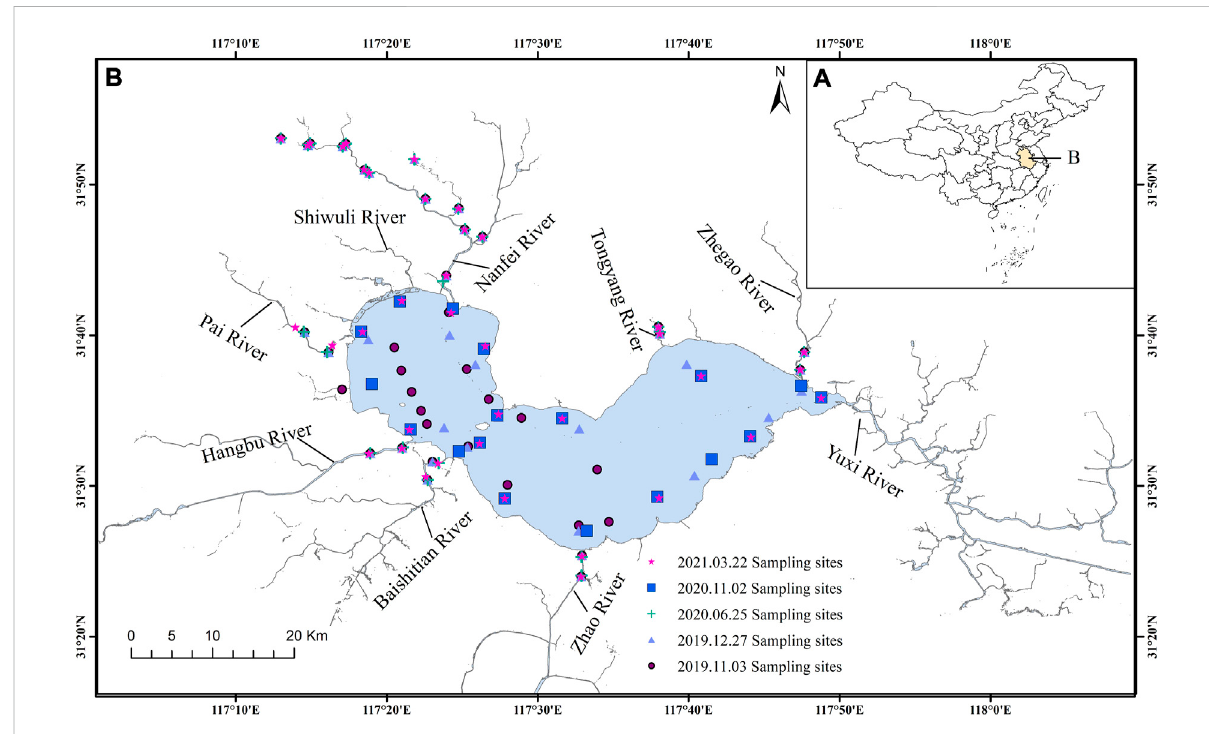
FIGURE 1 Location of Chaohu Lake and distribution of the sampling sites. (A) : China Map (B) : The location of study area in